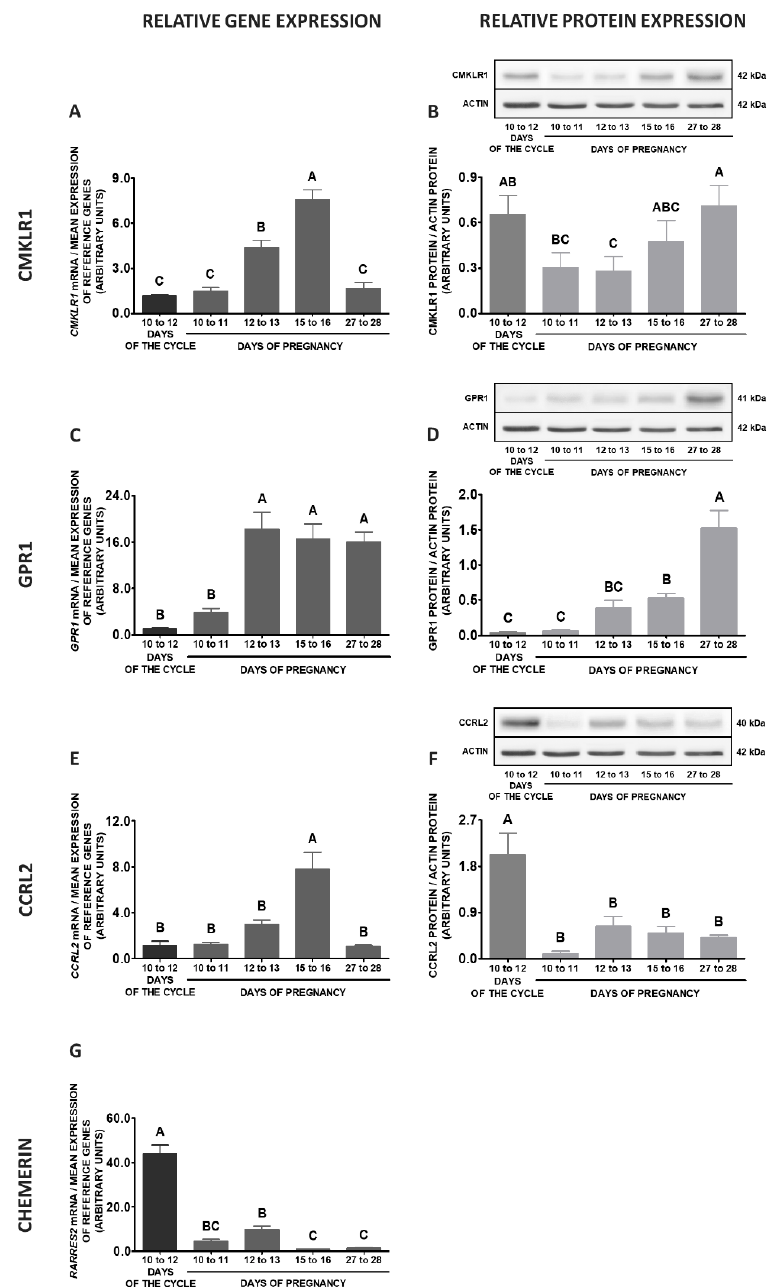
Figure 7. Chemerin system expression in the porcine mediobasal hypothalamus (MBH)—pregnancy vs. oestrous cycle. Gene and protein expression of chemokine-like receptor 1 (CMKLR1; A and B ), G protein-coupled receptor 1 (GPR1; C and D ) and C-C motif chemokine receptor-like 2 (CCRL2; E and F ), as well as chemerin ( RARRES2 ) mRNA content ( G ) in the porcine MBH on days: 10 to 11, 12 to 13, 15 to 16 and 27 to 28 of pregnancy, and on days 10 to 12 of the oestrous cycle. Gene expression was determined by qPCR. Protein expression was determined by Western blotting; upper panels: representative immunoblots; lower panels: densitometric analysis of CMKLR1/GPR1/CCRL2 proteins relative to actin protein. Representative actin blots are identical for all chemerin receptors though proteins have been analysed on different gels. Results are presented as means ± SEM ( n = 5). Bars with different superscripts differ (one-way ANOVA at p < 0.05 followed by Tuckey post-hoc test at p < 0.05).